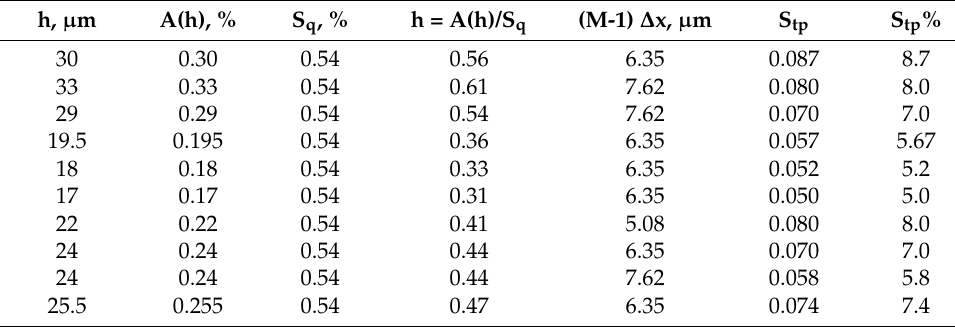
Table 5. The results of calculating the bearing capacity of the surface of AISI 304 steel after laser alloying with a plaster of 85Nb + 15% liquid